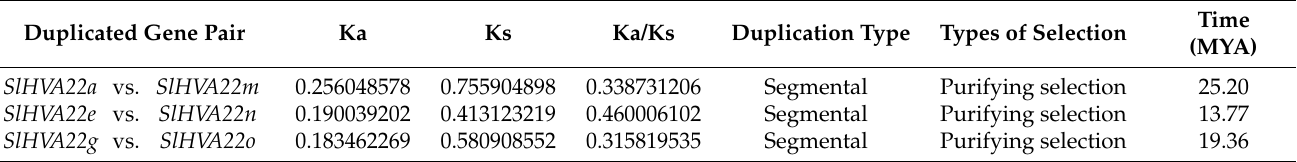
Table 1. Predicted Ka/Ks ratio of the duplicated SlHVA22 gene pair along with its divergence time.